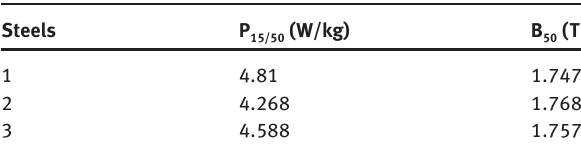
Table 4: Core loss and magnetic flux density of annealed